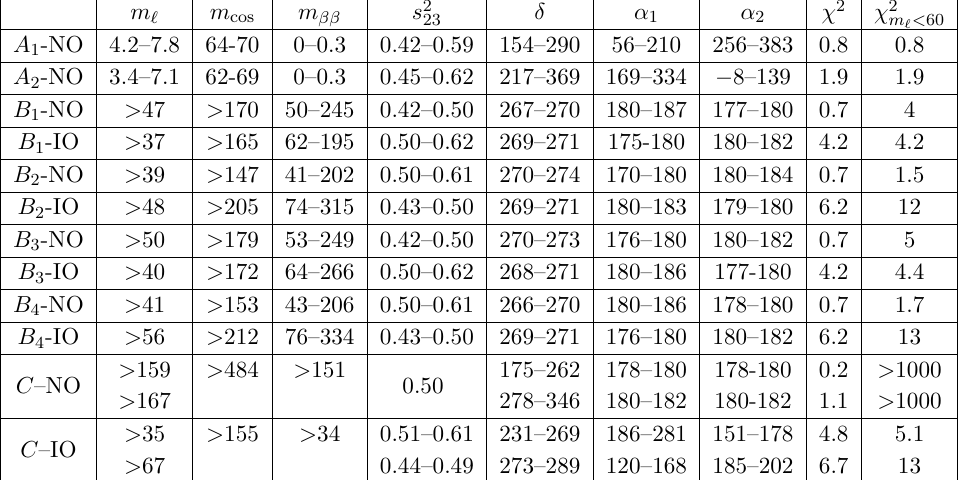
Table 1 . 99.73% C.L. results for the (cid:12)ts of the di(cid:11)erent textures. All masses are given in meV and all angles in degrees taken in the range [0 ; 360 (cid:14) ], except in some cases in which to avoid disjoint bands we have enlarged the region slightly below 0 (cid:14) or above 360 (cid:14) . IO (cid:31) 2 already include the 4 : 14 relative to NO obtained by the NuFIT collaboration but it is subtracted to compute the bands. We